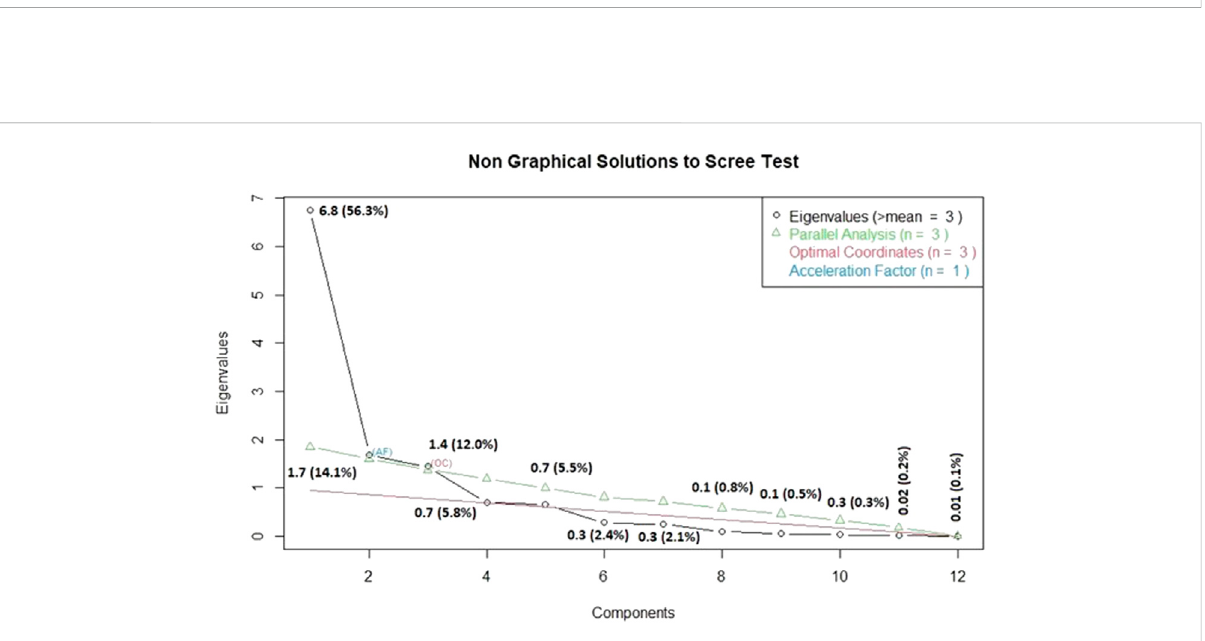
FIGURE 9 Scree plot for PM 2.5 data matrix obtained by PCA